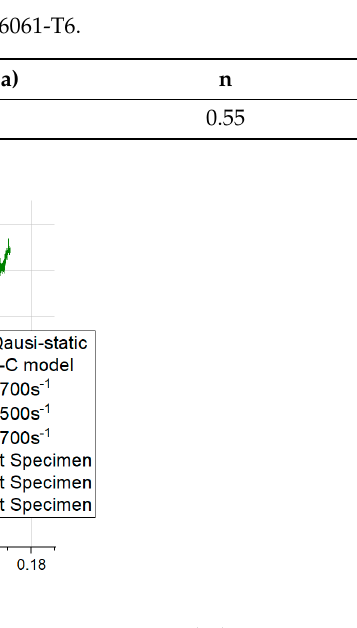
Figure 6. Johnson-Cook fitting model of the Al6061-T6 specimen with the SHPB experimental